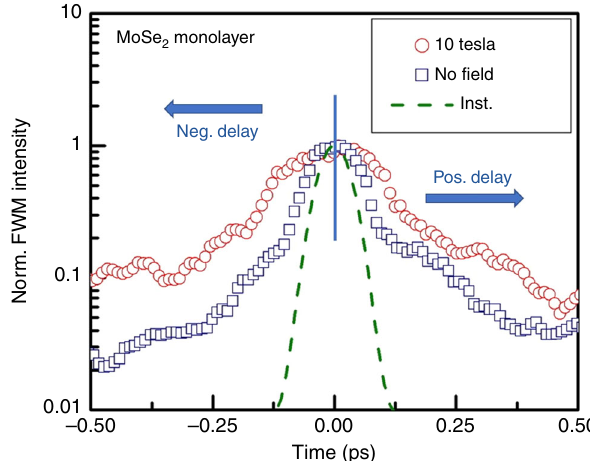
Fig. 2 Time-integrated FWM using linear polarizations. Time integrated FWM intensity as a function of the time delay at zero fi eld (blue squares) and 10 T (red circles) using linear horizontal polarizations. The dashed green curve corresponds to the instrumental response. The positive time delay corresponds to the pulse sequence shown in Fig. 1c, whereas negative time delay corresponds to the pulse sequence shown in Fig. 1d. The phase conjugate pulse A * is scanned continuously from negative time delay (arriving at the sample last) to positive time delay (arriving at the sample fi rst). The time delay T between pulses B and C is kept fi xed at 0 C and detection, respectively 19,50 . The cocircular polarizations lead to exciton formation in only one valley K , whereas using the cross-circular polarizations excitons in different valleys K and K ′ are created. The time-integrated FWM data for cocircular and cross-circular polarizations are shown in Fig. 3a, b, respectively.